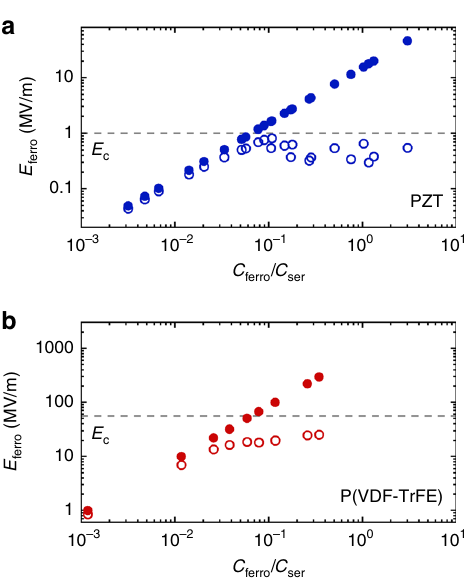
Fig. 4 Internal electric fi eld. Internal electric fi eld as a function of the ratio of capacitances for a Pb(Zr,Ti)O 3 (PZT) and b poly (vinylidene fl uoride – tri fl uoroethylene) [P(VDF – TrFE)]. The solid circles represent the initial electric fi eld, directly after the applied voltage drops to zero and the induced polarization is discharged. The open circles represent the retained values of the fi eld after depolarization. The dashed lines represent the corresponding coercive fi eld. When the initial internal fi eld is much lower than the coercive fi eld, there is no depolarization and the initial and fi nal internal fi elds are identical. When the initial internal fi eld is much larger than the coercive fi eld, the ferroelectric material depolarizes until the fi nal internal fi eld is stabilized at the coercive fi eld, regardless of the ratio C C ferro / ser NATURE COMMUNICATIONS| (2019) 10:2547